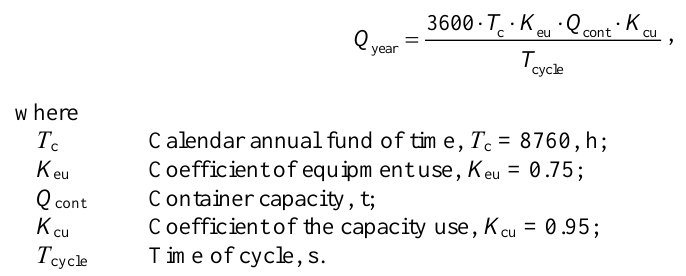
Fig. 1. Plan of energy-saving container technology in opencast mining: 1 – containers under loading; 2 – container carriers; 3 – containers on the platform at the hoist. The hoist capacity is justified by required productivity of the open-pit mine. The productivity of the hoist Q year , thous. t/year will be determined depending on the time of its operating cycle T c according to the equitation